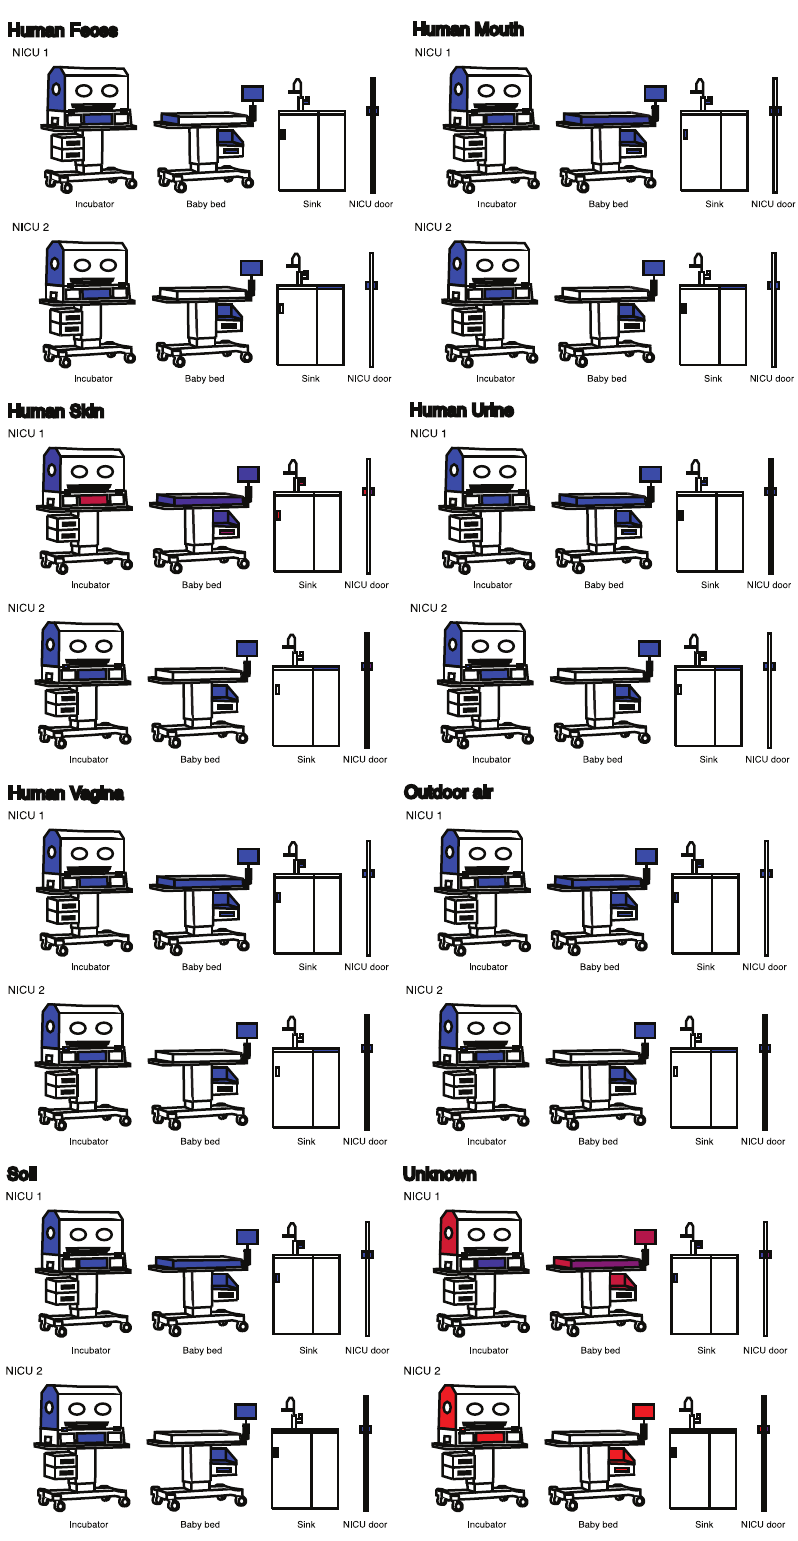
Figure 2. Likely sources of microbes in the two NICUs. SitePainter images display the results from SourceTracker. The NICU sites are colored on a heatmap scale, where blue indicates that low similarity between a sink and a source and red indicates high similarity between a sink and a source Many surfaces have microbial compositions that are not similar to any of the sources (represented by Unknown), while the handles of the drawers, door and faucet, and the keyboard of the incubator, resemble the communities of human skin.